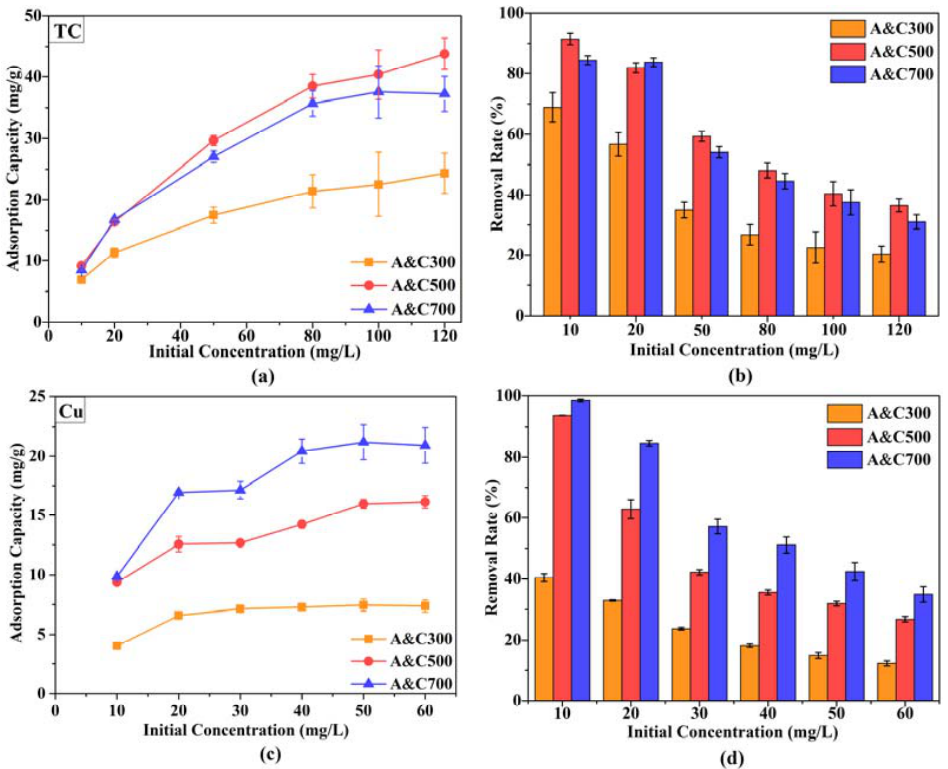
Figure 2. The adsorption performance and removal efficiency of A&Cs for ( a , b ) TC, and ( c , d ) Cu( Ⅱ ).